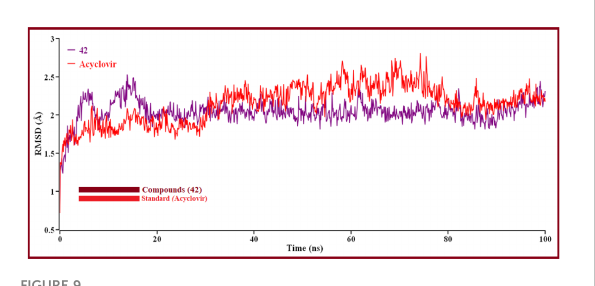
FIGURE 9 The RMSD of C a atoms over time for proteins and ligands. Here, red and violet lines denote compound 42 and Acyclovir complexes,